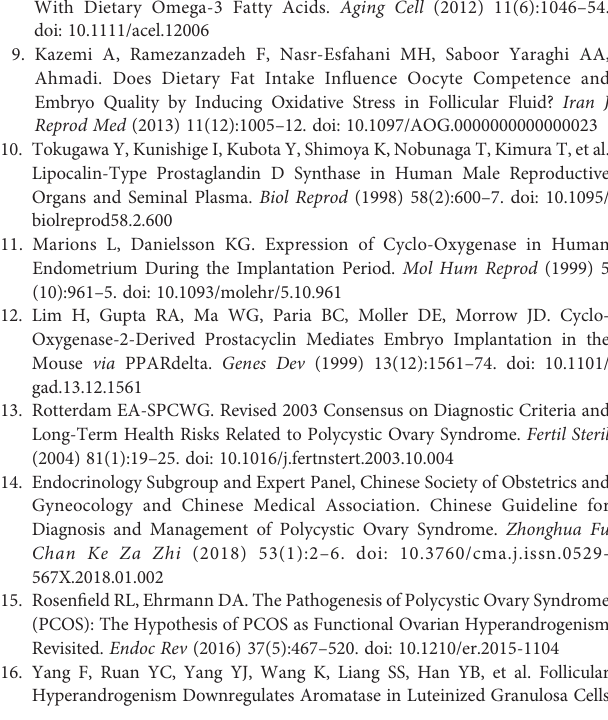
Supplementary Table 1 | Comparison of fatty acid levels between the overweight PCOS patients 、 the overweight control subjects 、 the normal PCOS subjects and the normal control subjects. Supplementary Table 2 | Analysis of differences in gene expression between the two